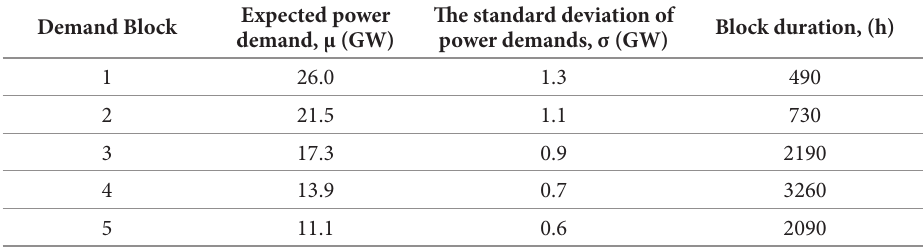
Table 1. Power demand during the year